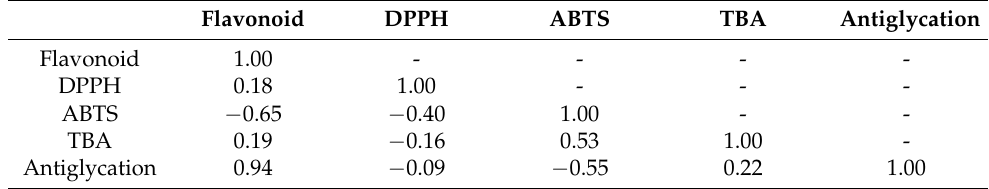
Table 2. Correlation coefficient of total flavonoid content, antioxidant and antiglycation activities. Flavonoid DPPH ABTS